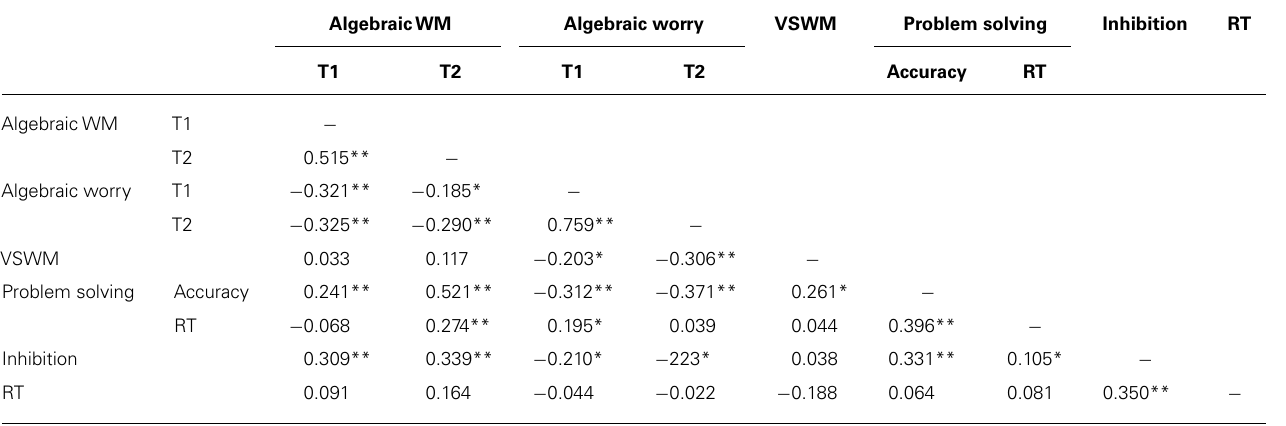
Table 2 | Correlation for algebraicWM recognition accuracy, worry ratings,VSWM, problem solving accuracy and response time,VSWM, inhibition and basic response